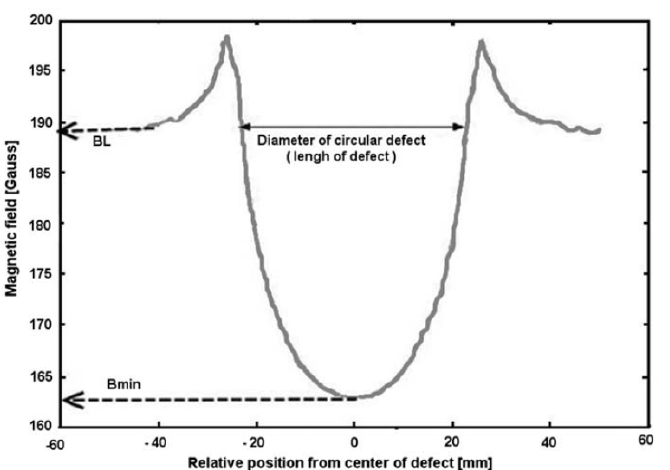
Figure 27. The visualisation of the dimensions of a corroded area on the wall of a pipeline using ICS. Reprinted from NDT & E International, Volume 42, Gloria, N.B.S.; Areiza, M.C.L.; Miranda, I.V.J.; Rebello, J.M.A., Development of a Magnetic Sensor for Detection and Sizing of Internal Pipeline Corrosion Defects, Page 669–677, Year 2009 with permission from Elsevier